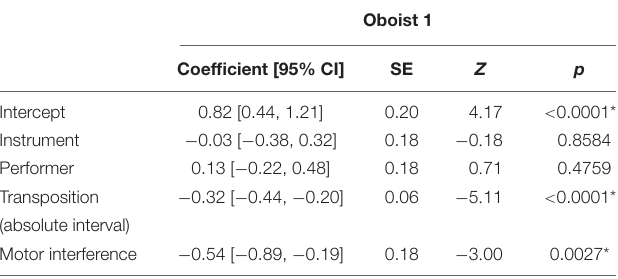
TABLE 4 | Main results from exploratory logistic regression of accuracy on the four condition variables with transposition operationalized as a continuous (rather than binary) variable describing the absolute number of semitones that pitch-shifted stimuli were